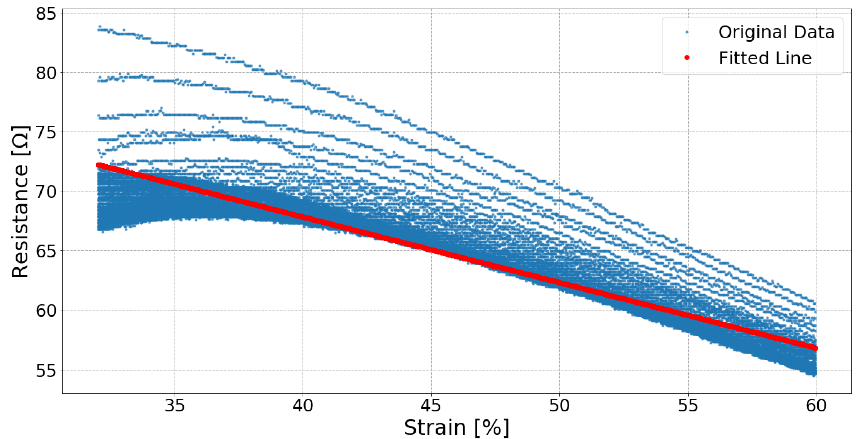
Figure 6. Sample 15, a silver-plated sensor (Technik-tex P130B), response and the fitted line from 32% strain to 60% strain while stretching.